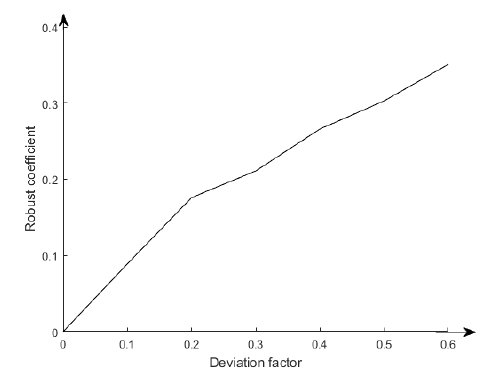
Figure 3. The relationship between the robust coefficient and the deviation factor curve.